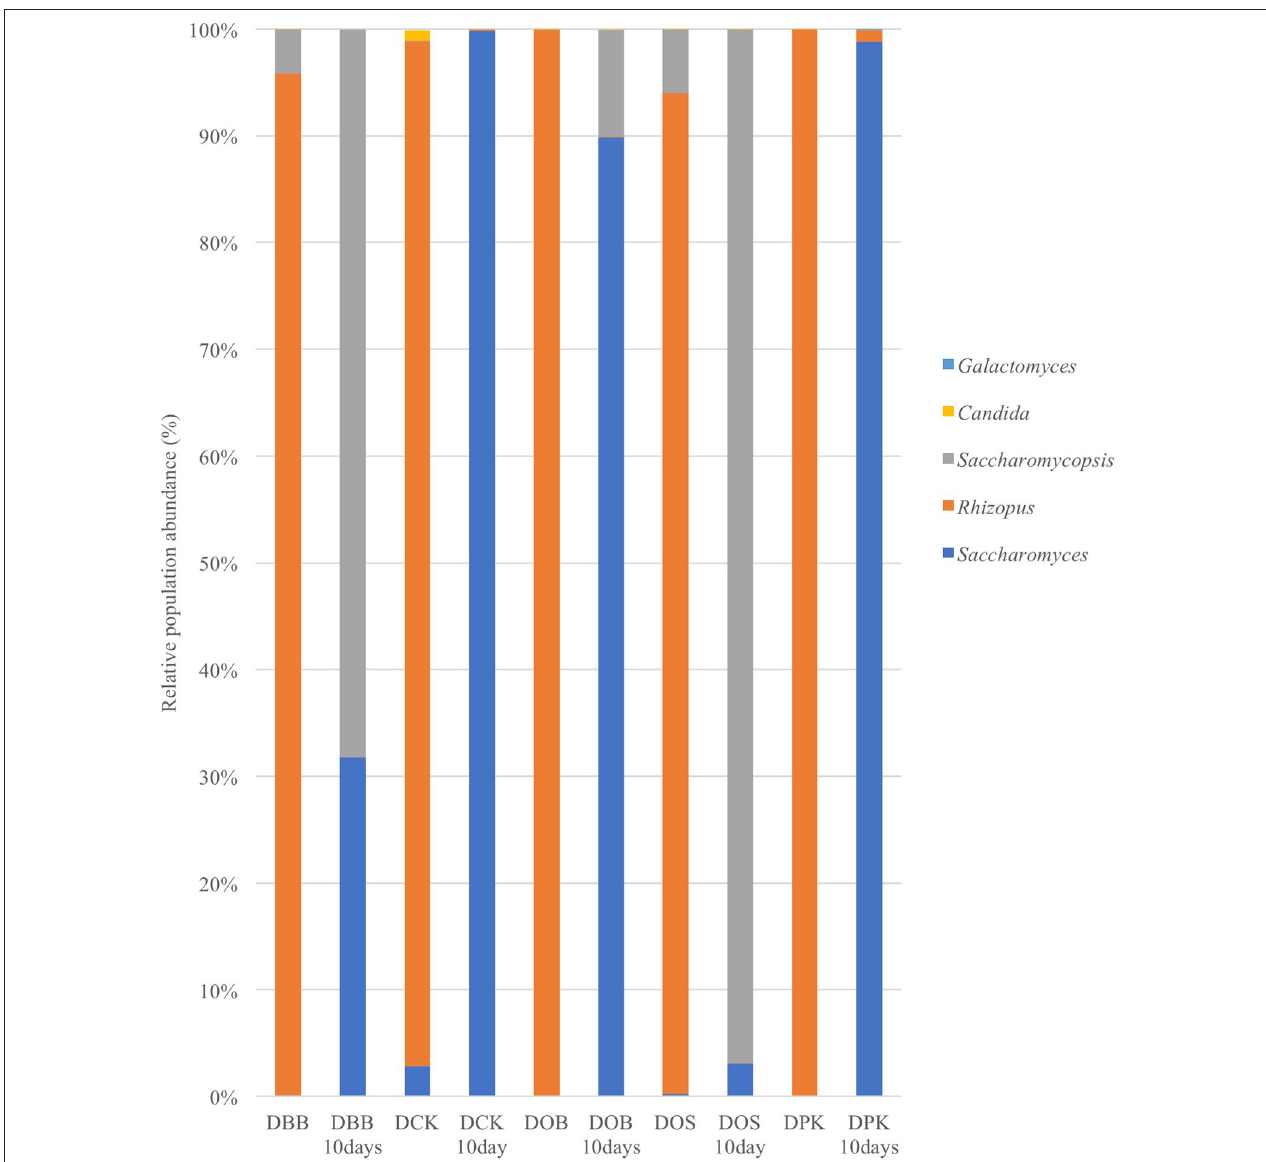
FIGURE 3 | Fungal composition (OTUs at the genus level based on 26S amplicon sequencing) of the five starters and the corresponding microbial communities after 10 days of fermentation (labeled “10 Days”). DBB, DCK, DOB, DOS, and DPK are the five traditional Cambodian starters.